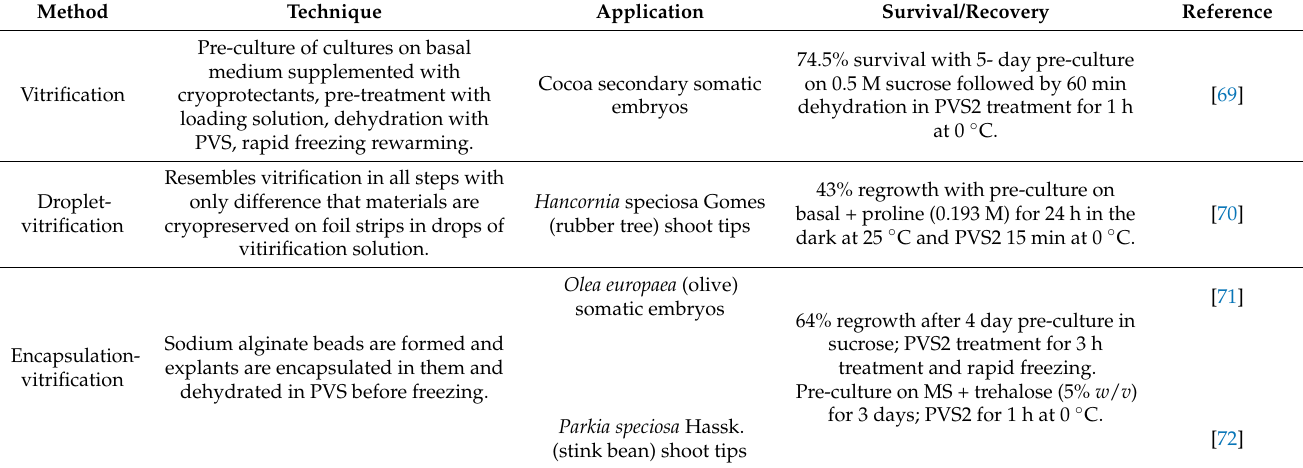
Table 5. Some examples of cryopreservation methods, techniques and applications